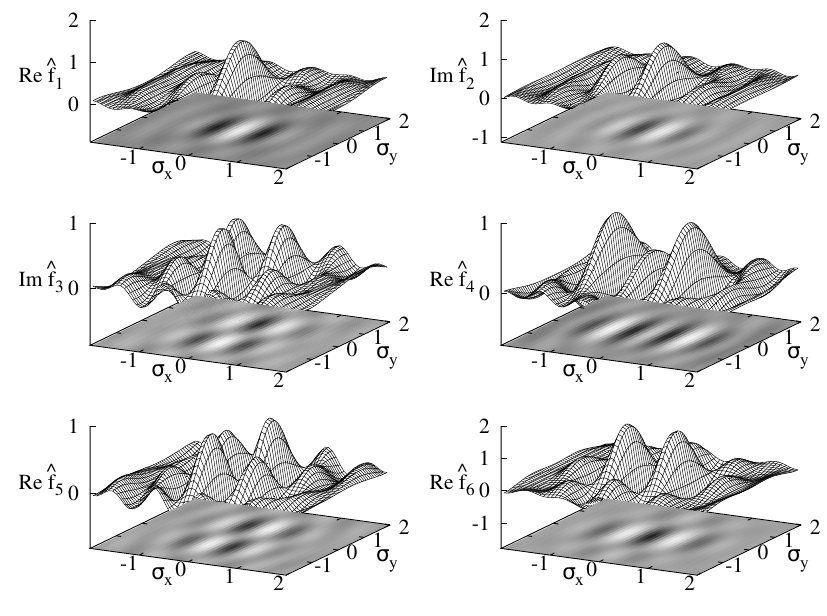
Fig. 4. The Fourier transforms of basis functions f 1 to f 6 for q = 1 =